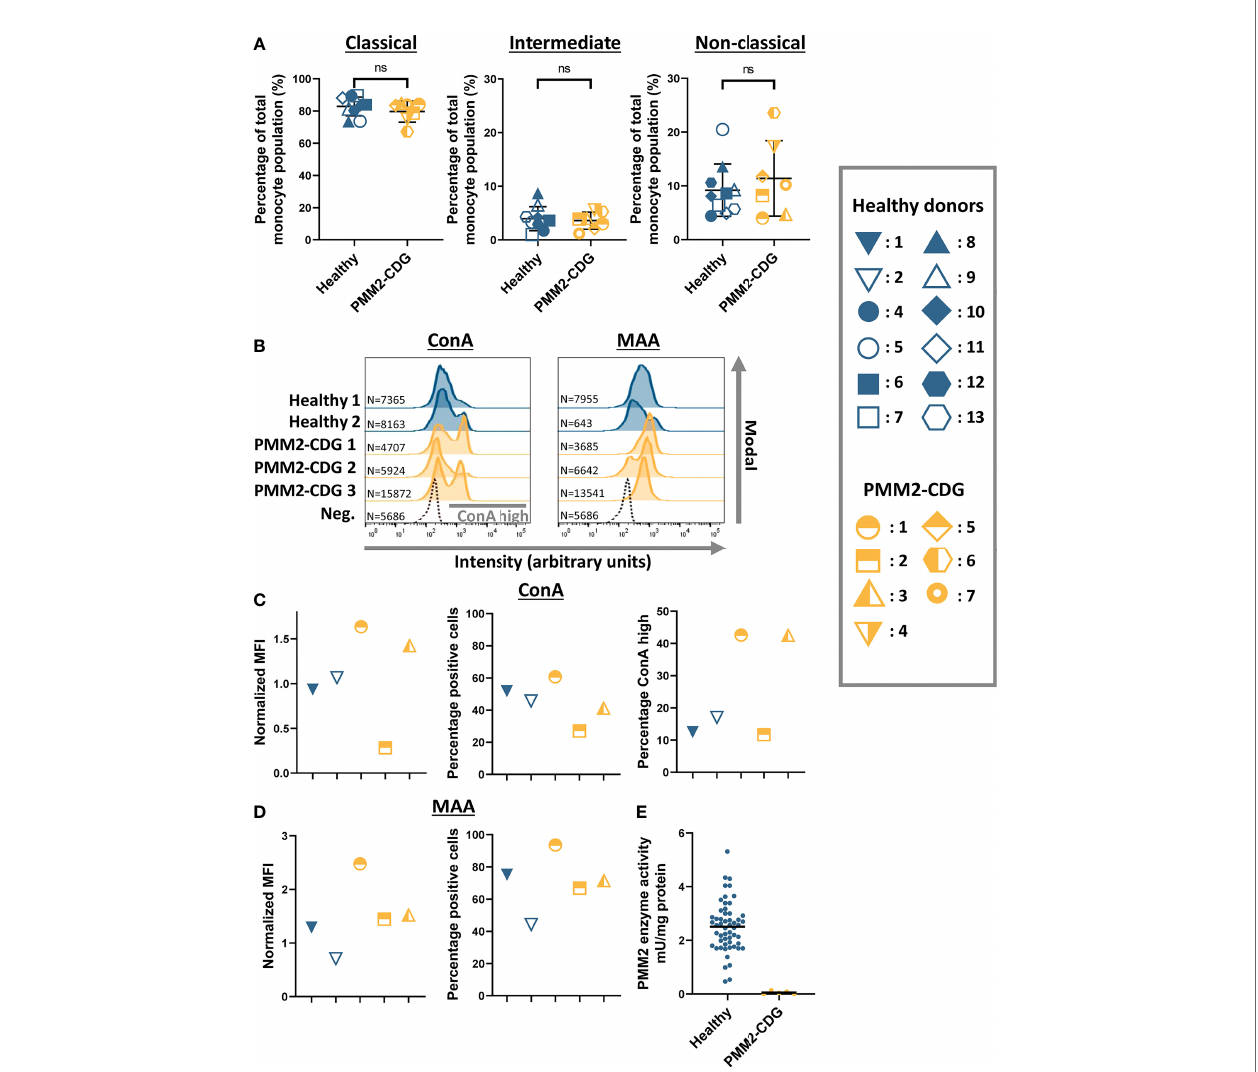
FIGURE 1 | Characterization of monocytes from PMM2-CDG patients (A) The relative abundance of monocyte subpopulations divided into classical (CD14 ++ CD16 - ), intermediate (CD14 + CD16 + ) and non-classical (CD14 ++ CD16 + ) monocytes in healthy control (n = 10) and PMM2-CDG patient PBMCs (n = 7). (B) Histogram plots showing the intensity of fl uorescently labelled lectins (ConA and MAA) bound to monocytes (CD14+) on a logarithmic scale. The modal is used to represent the data which scales the plot as the proportion of the maximum count. Absolute cell numbers (N) are indicated. For simplicity, here we indicate only the unlabelled negative control (Neg.) related to sample Healthy 2 as representative plot. (C, D) Quanti fi cation of the histogram plots showing the median fl uorescent intensity (MFI) normalized to the average MFI (set as 1) of the healthy controls (C ConA; D MAA). Before normalization, the MFI values of the negative controls were subtracted. ConA binding resulted in some conditions in two de fi ned subpopulations (see grey bar in B), the percentage of ConA high from the total cell population is also plotted. (E) PMM2 enzyme activity in leukocytes isolated from healthy donors (n = 56) and PMM2-CDG patients (n = 5). Results are summarized in Table 1 . Mean ± S.D. Signi fi cance was calculated by unpaired Student ’ s t-test (A) . ns, non-signi fi